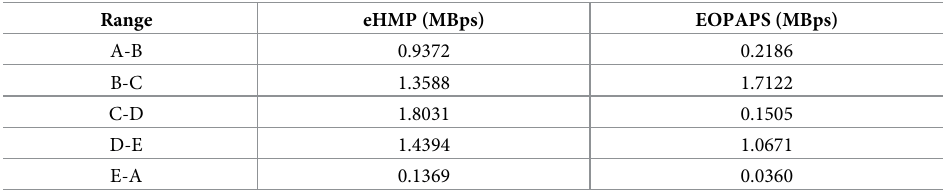
Table 1. Average throughput between eHMP and EOPAPS in each